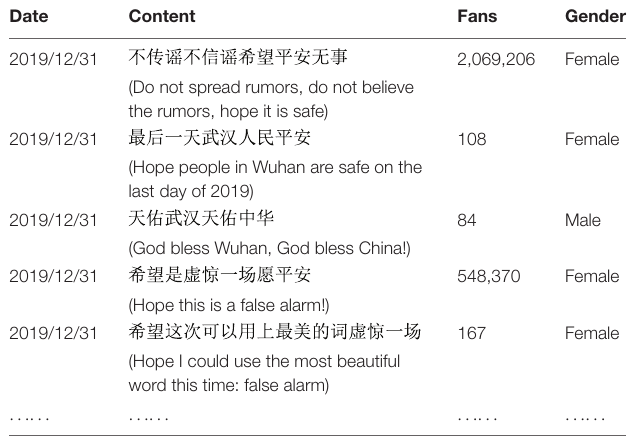
TABLE 1 | Comments after preprocessing.